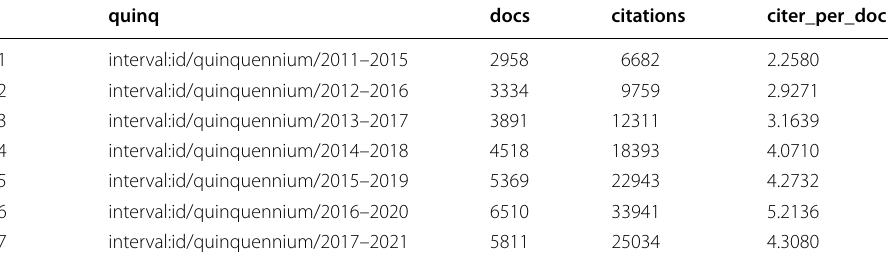
Table 7 Results Cypher query: calculate cites per publication?